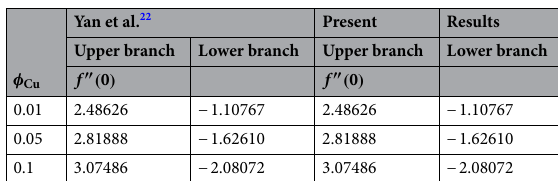
0.1, (cid:31) 1 0 and δ K M = = = = =